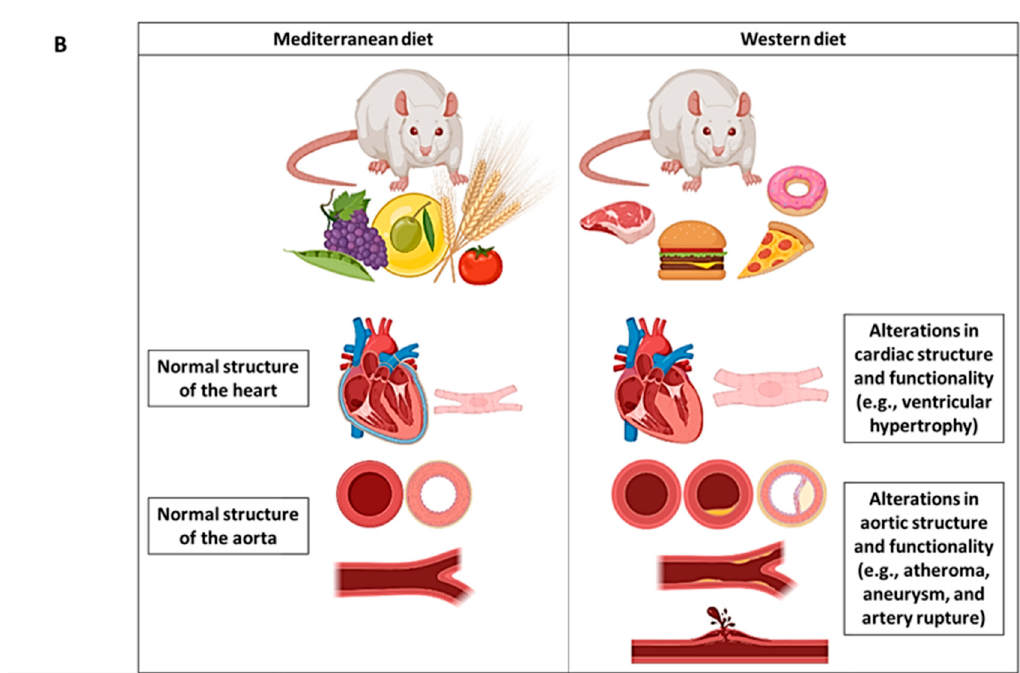
Figure 5. ( A ) Summary of the influence of the type of fat in the diet on the regulatory activities of the renin–angiotensin system, cardiac biomarker leucine aminopeptidase, and dipeptidyl peptidase IV. ArgAP: arginyl aminopeptidase; CysAP: cystinyl aminopeptidase; DPP-IV: dipeptidyl peptidase IV; GluAP: glutamyl aminopeptidase; LeuAP: leucyl aminopeptidase; pGluAP: pyroglutamyl aminopeptidase. VOO: diet enriched with virgin olive oil; Bch: diet enriched with butter plus cholesterol. ( B ) Differences in cardiovascular physiology with a long-term Mediterranean diet or Western diet at the structural or functional level in the heart and aorta.